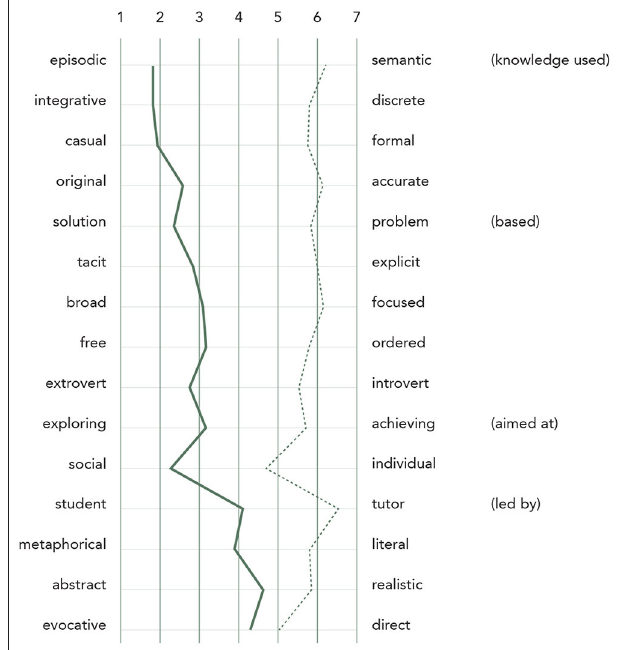
FIGURE 1 | The difference between a design studio (solid line) and an engineering lab class (dashed line) based on the work of Ismail bin Samsuddin ( Lawson and Dorst, 2009, p.235). These semantic differentials informed the development of the case study and the proposed Community Based Designerly Scale presented in Section 6.1.